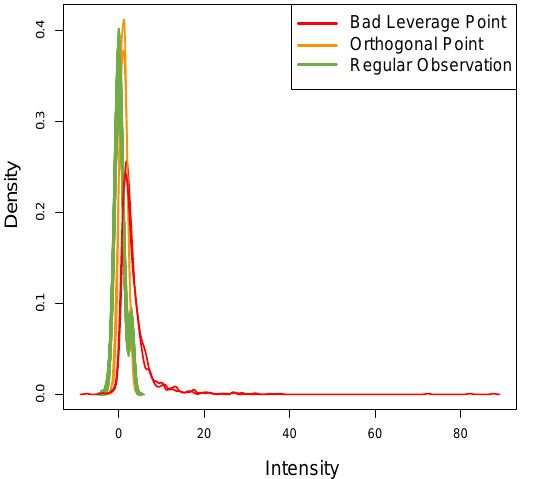
Figure 8. Density plot of samples of second synthetic dataset, grouped by